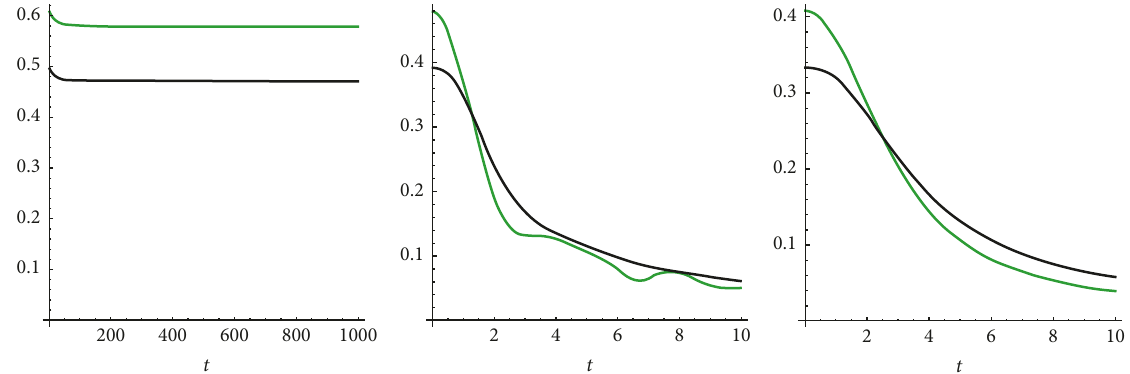
Figure 13: Plots of 𝐻(𝑡)/√𝑀 0 (black) and 𝐻 𝑐 (𝑡)/√𝑀 0 (green) for the yellow trajectory in the potential Φ 0 and for the orange trajectory in the potentials Φ 0 and Φ − , respectively. For better clarity, we truncated the plots at convenient values of 𝑡 .